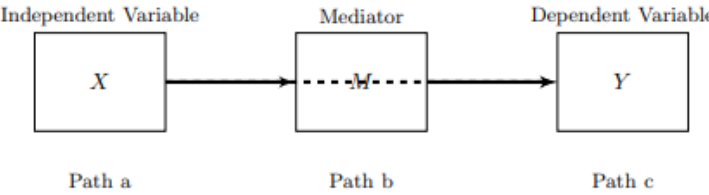
Figure 4. Simple mediation model (source: own elaboration).